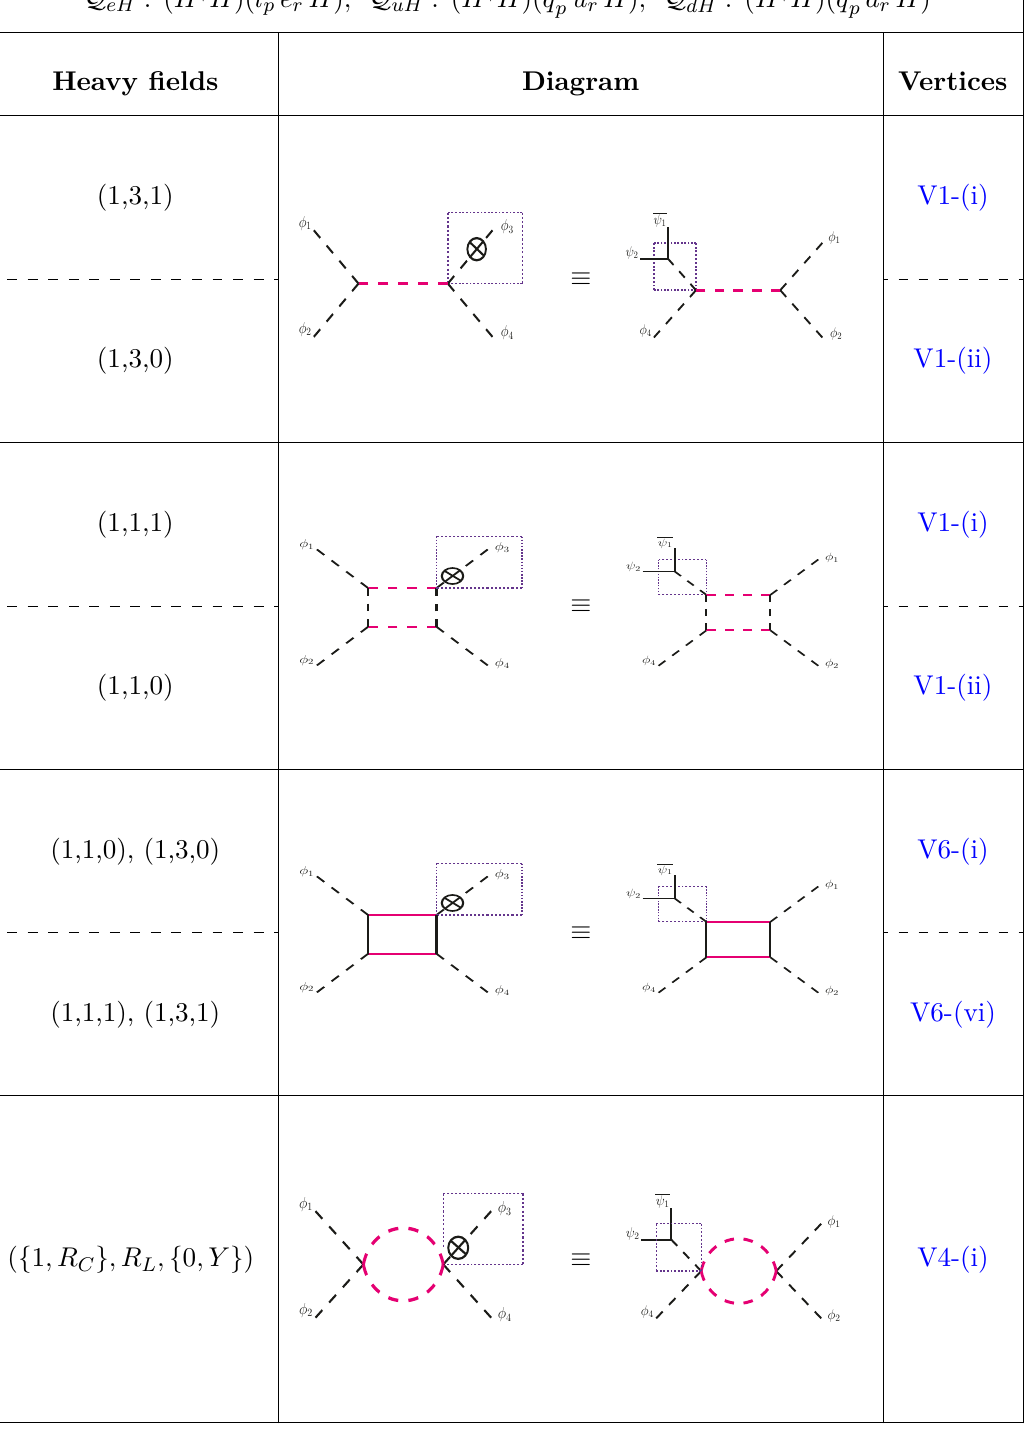
Table 8 . Heavy field representations that indirectly provide non-zero contributions to the ψ 2 φ 3 operators when the equation of motion of the SM Higgs is implemented, in the process of unfolding φ 4 D 2 class of operators. Also, listed are the vertices corresponding to the